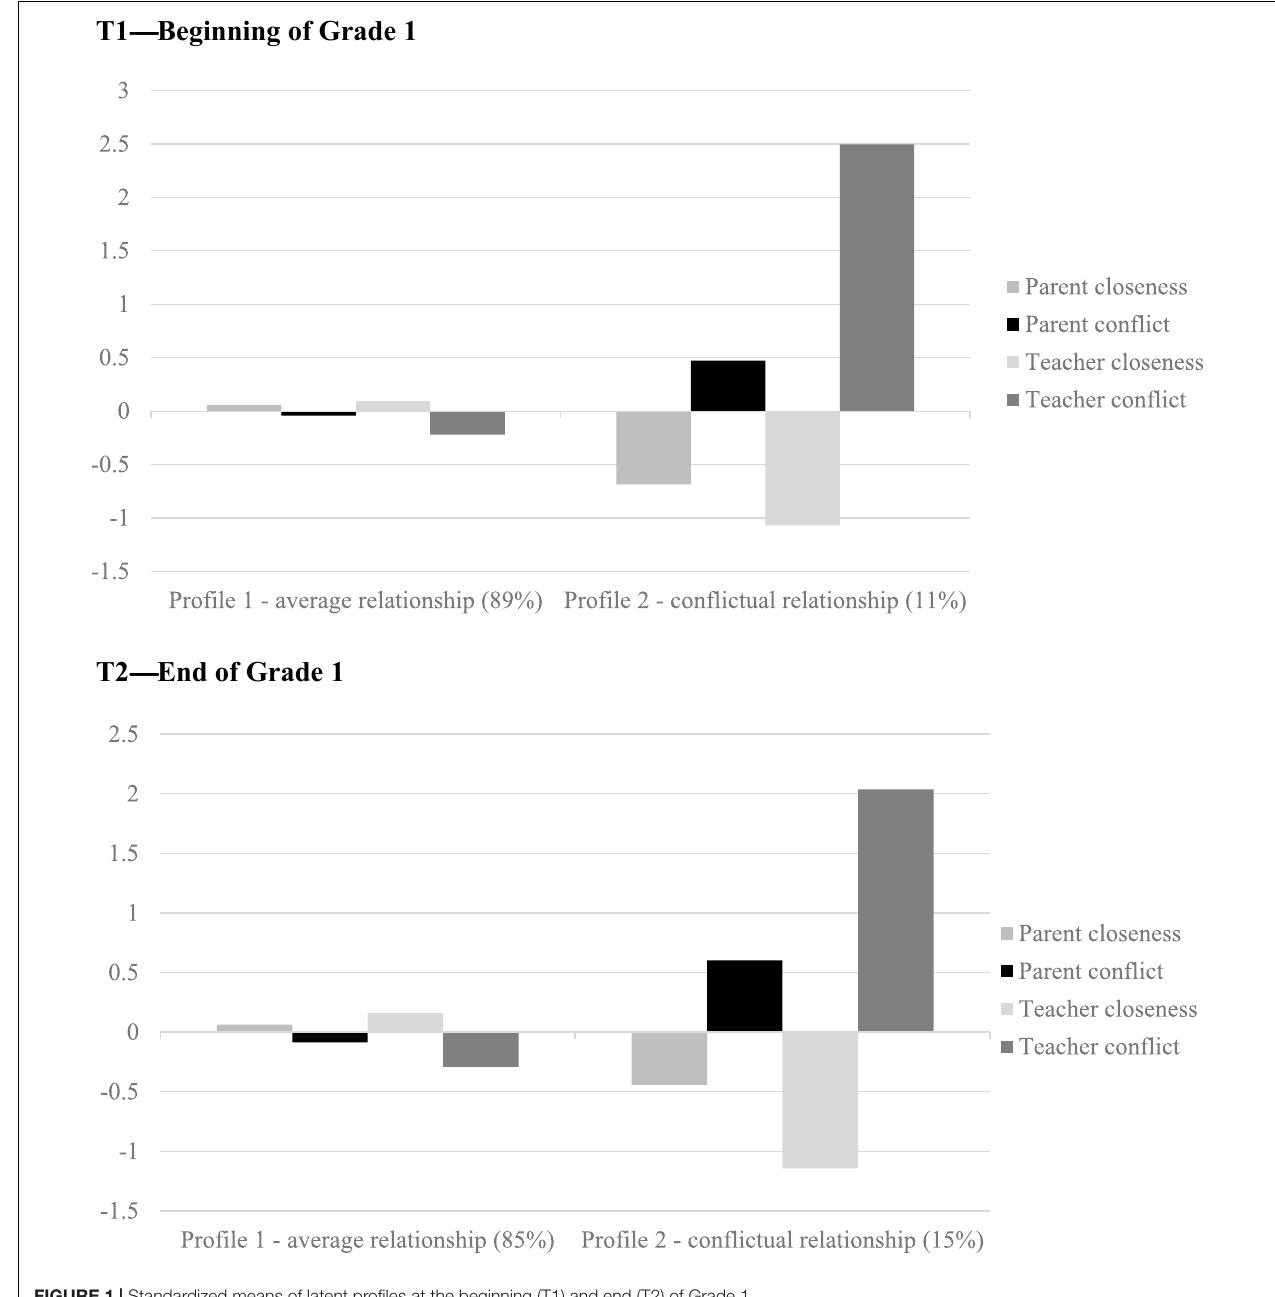
FIGURE 1 | Standardized means of latent profiles at the beginning (T1) and end (T2) of Grade